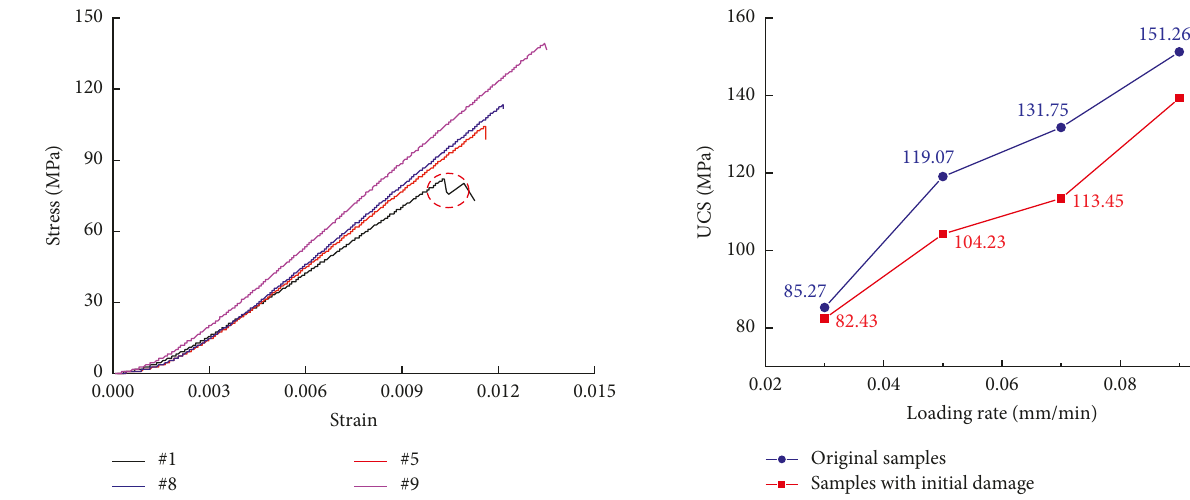
Figure 6: Relationship between the loading rate and uniaxial compressive strength (UCS).